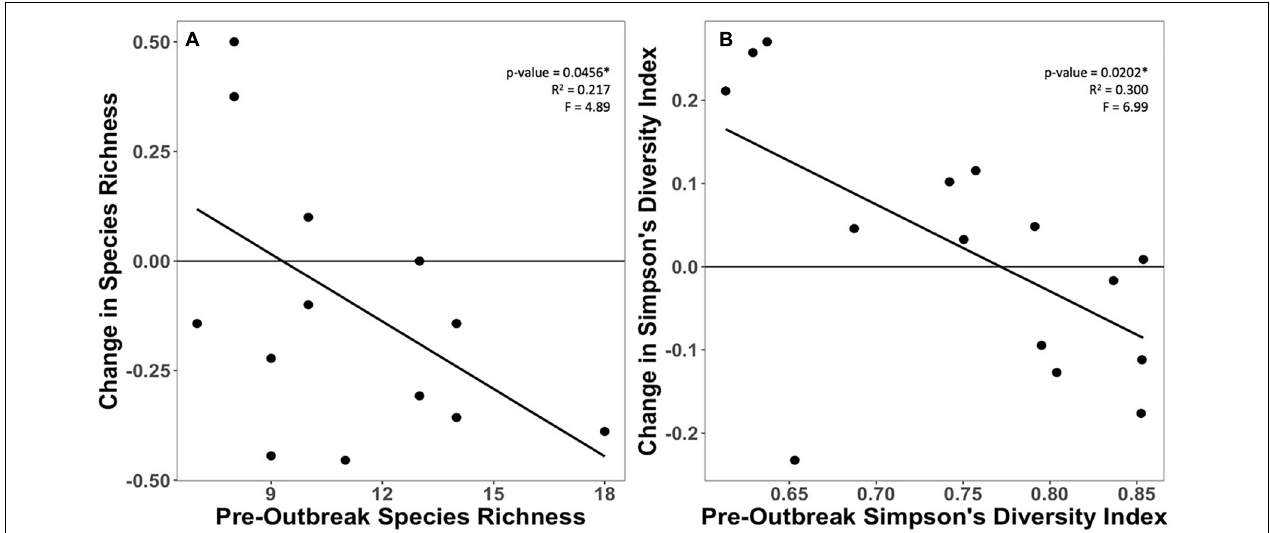
FIGURE 5 | Relationship between pre-outbreak (A) species richness and (B) Simpson’s diversity, and each metric’s respective proportional change in the endemic zone.